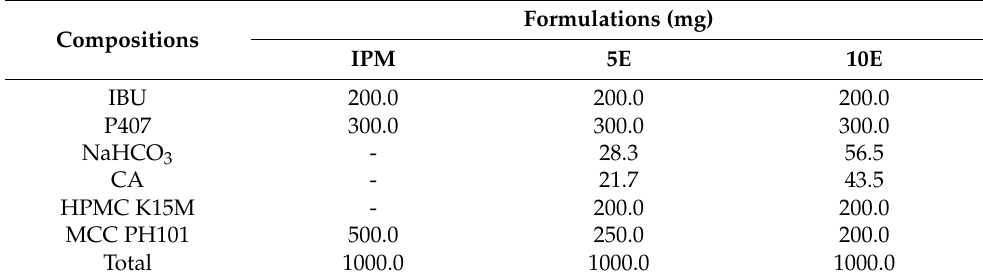
Table 1. Compositions of IBU-P407 effervescent matrix tablets.